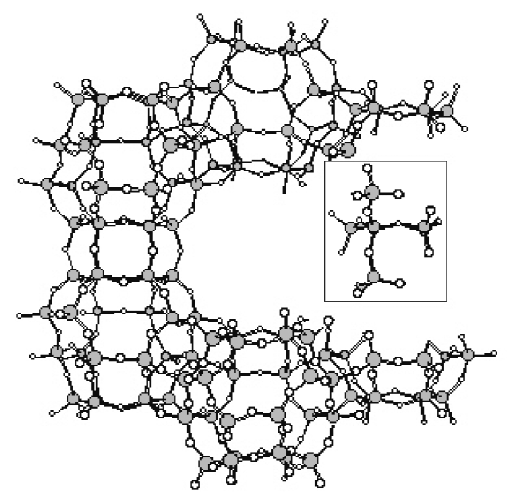
Fig. 11. Structure of an all-Si zeolite with « cages » of variable dimension and coordination number de- termined by SiO 4 4– network connectivity. Inset: irre- ducible representation of « starblock-like » copolymers composed of (identical) interacting A - A monomers of same Kuhn length. Interaction parameter χ AA is that arising from HPM treatment. Bending between adja- cent polymers depends on value attained by χ AA and determines medium-range order. Long-range perio- dicity is locally interrupted by depolymerization, and relative arrangement of starblock-like copolymers may contribute to structural instability (and conse- quent unmixing) through strain energy